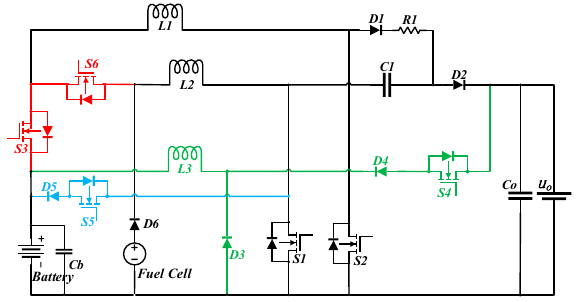
Figure 1. The Structure of Integrated Converter for Fuel Cell Hybrid Vehicle.